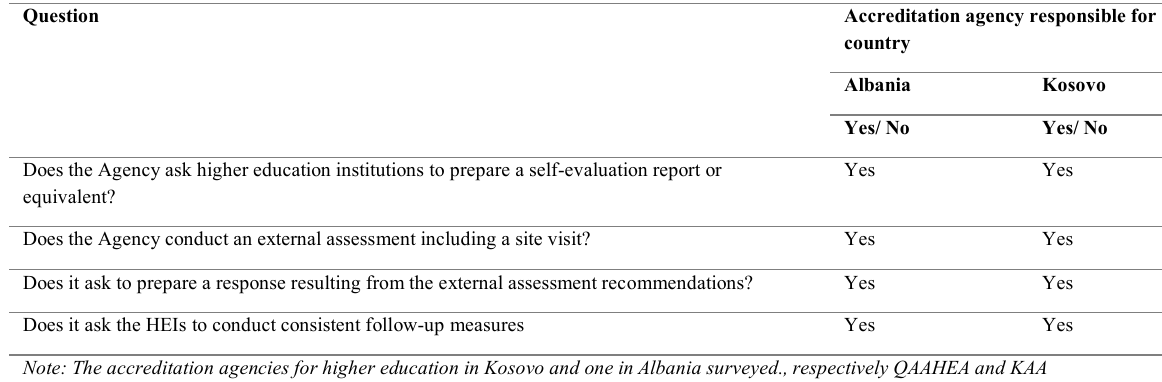
Table 17 : External quality assurance: Peer-review experts and criteria for outcomes (KAA and QAAHE)